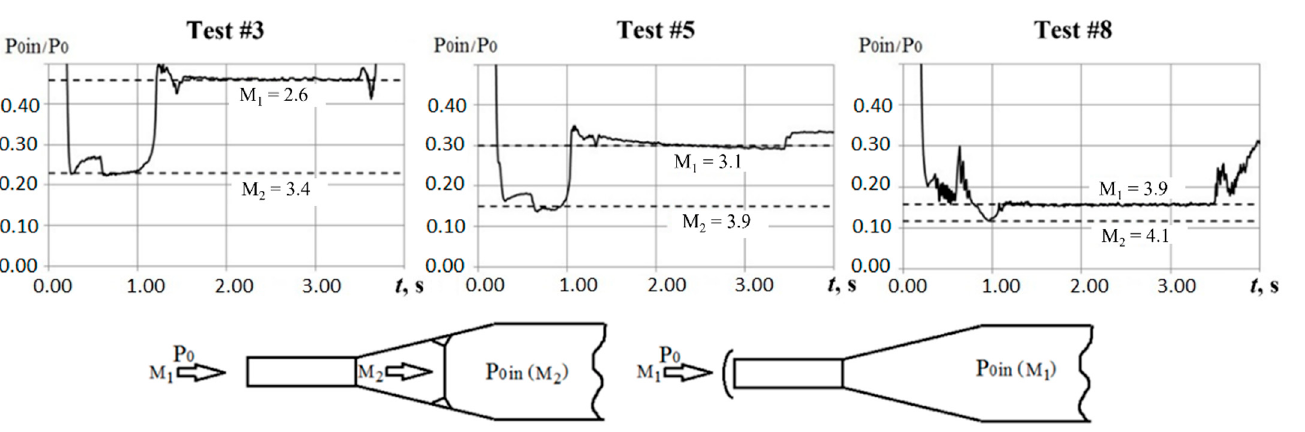
Figure 7. Formation of a diverted head shock at the GG intake in test fires with LSM sample combustion.